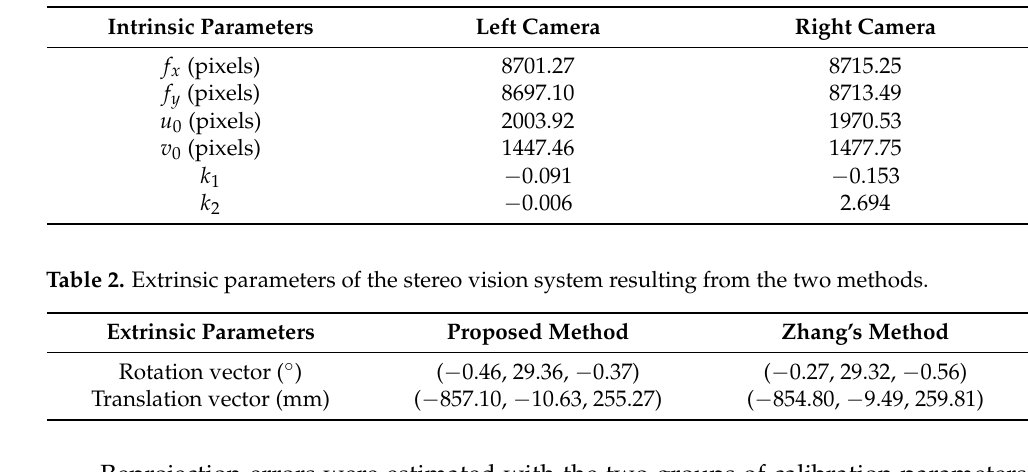
Table 1. Intrinsic parameters of the stereo vision system.